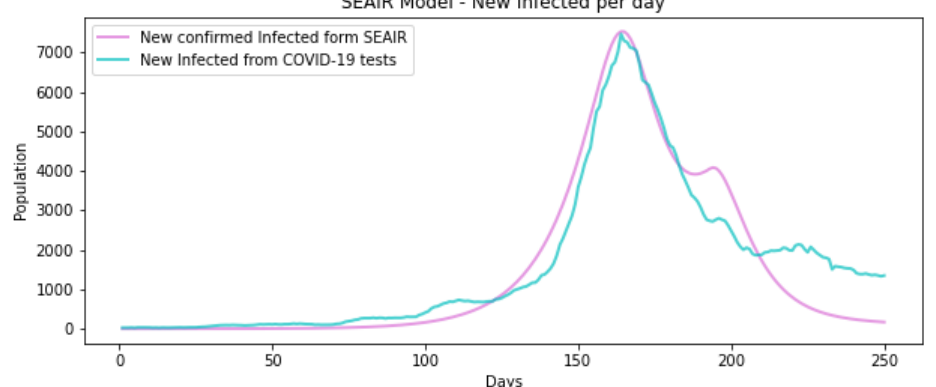
Figure 4. Comparison of newly infected people between SEAIR model and COVID-19 tests in Austria. Second wave.